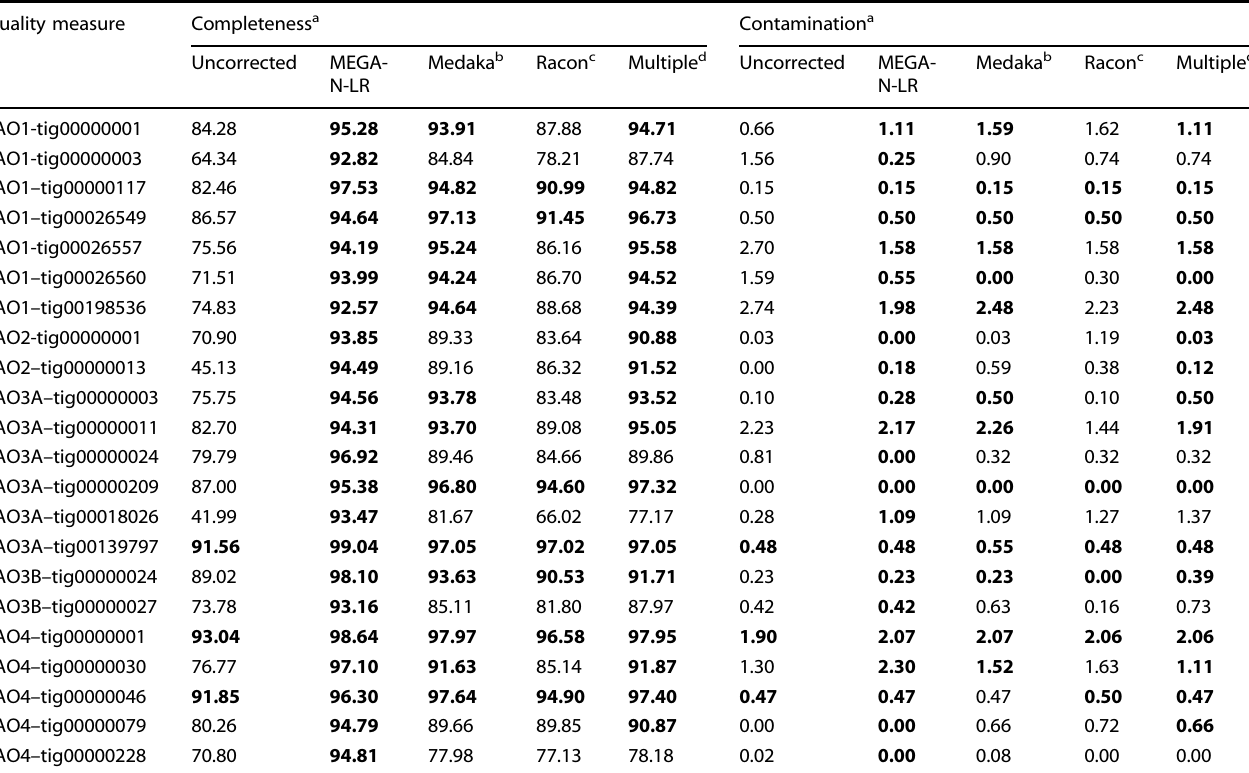
Table 2. In fl uence of sequence correction procedure on CheckM – derived genome quality statistics. Quality